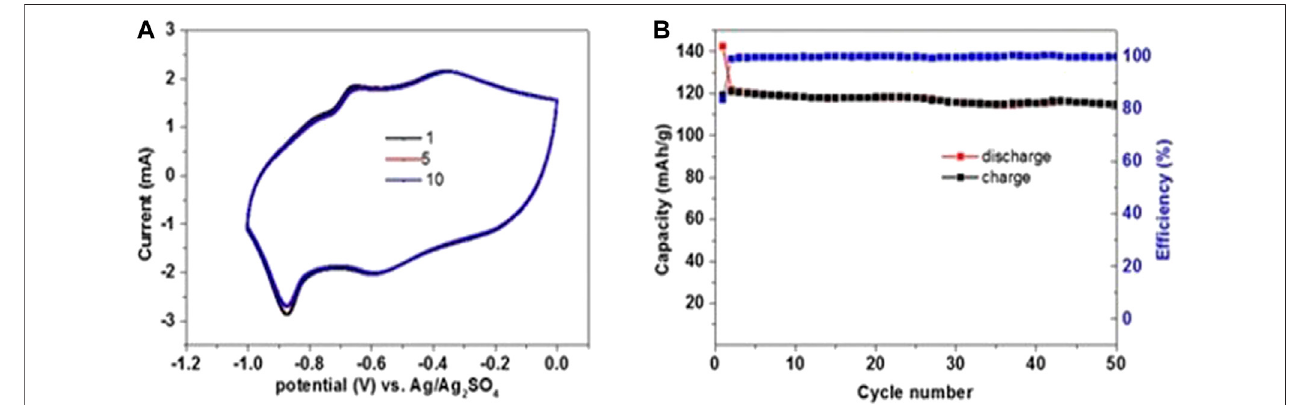
FIGURE 8 | (A) CVs of PI electrodes in 3 electrodes ’ cells, using counter electrodes containing excess of NMO and Ag/Ag 2 SO 4 reference electrodes in saturated